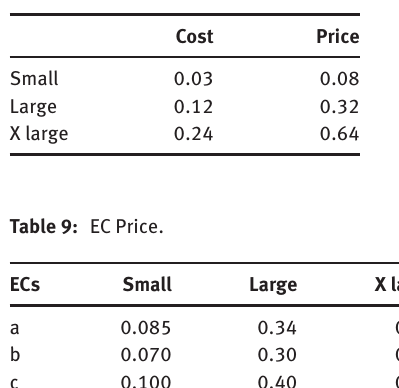
Table 8: Private Cloud’s Cost and Price.